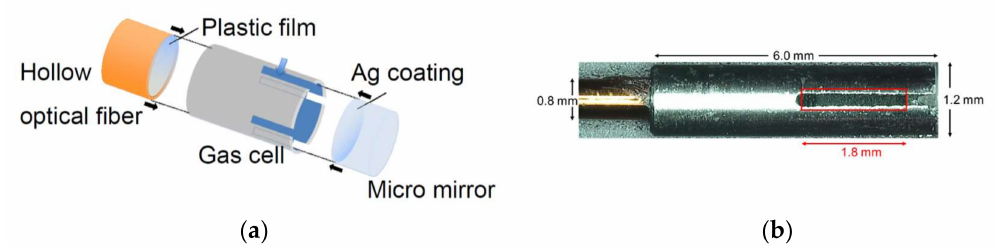
Figure 4. ( a ) Schematic structure and ( b ) appearance of fabricated miniature gas cell. The hollow optical fiber is on the left of the picture.